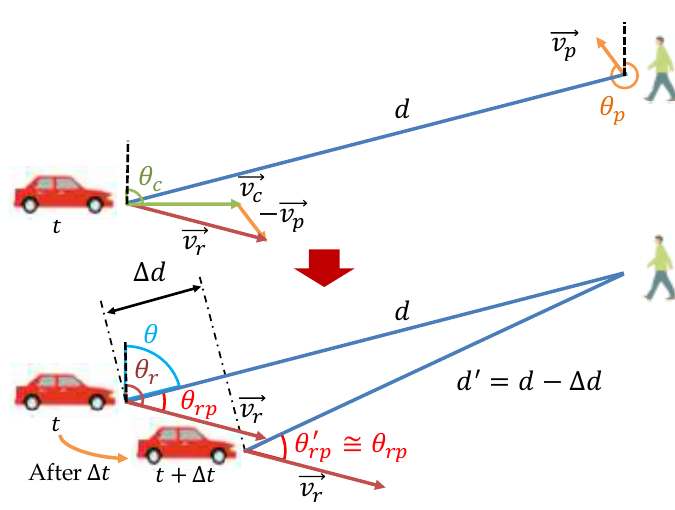
Figure 5. Change of signal propagation distance during ∆ t